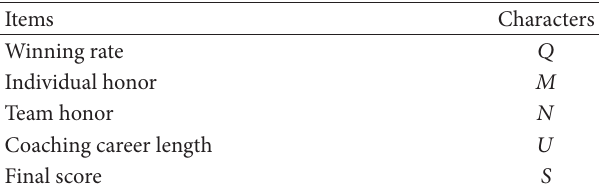
Table 4: Variable definitions mentioned in Model